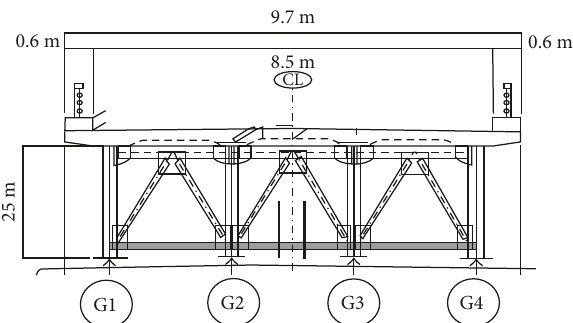
Figure 9: Plan view.